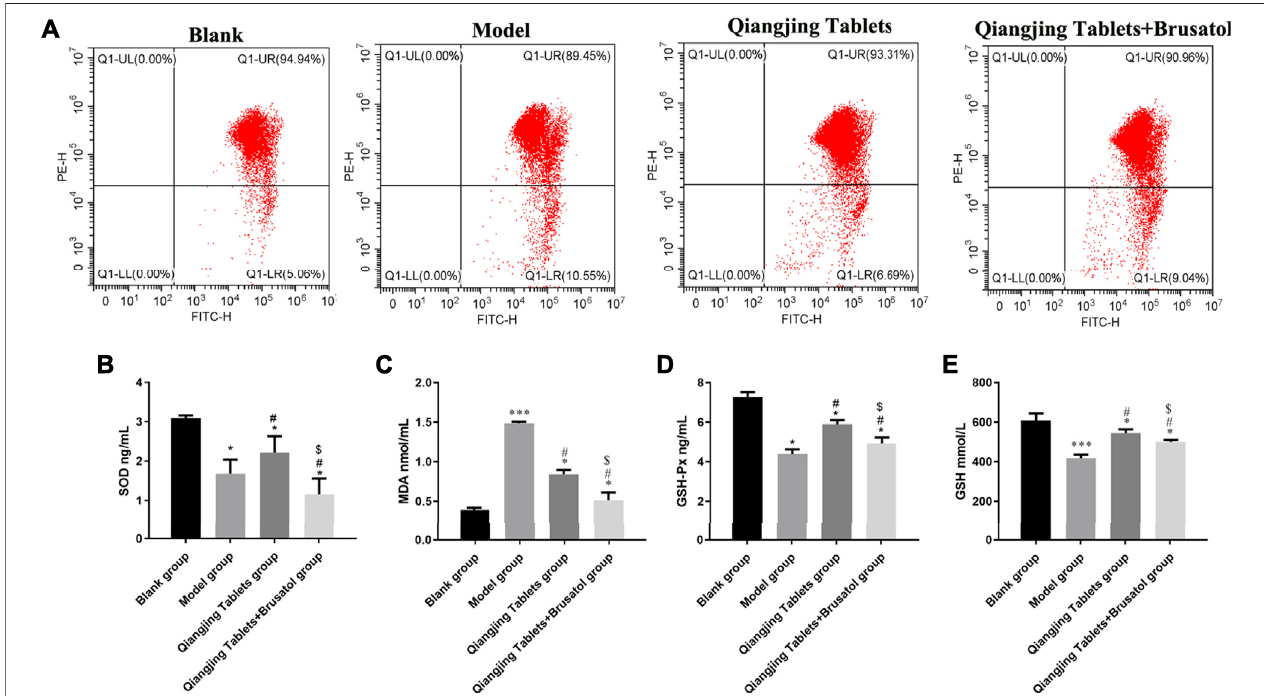
FIGURE 6 | Effect of Qiangjing Tablets on mitochondrial damage and oxidative stress of sperm in AZS rats. (A) JC-1 for mitochondrial damage in Blank, model, Qiangjing Tablets, and Qiangjing Tablets + Brusatol groups. (B – E) ELISA for activity SOD and GSH-Px, and content ofMDA and GSH in testis. Values are expressed as mean ± SD, n (cid:2) 15 per group. * p < 0.05 vs. Blank group; *** p < 0.001 vs. Blank group; # p < 0.05 vs. model group; $ p < 0.05 vs. Qiangjing Tablets group.